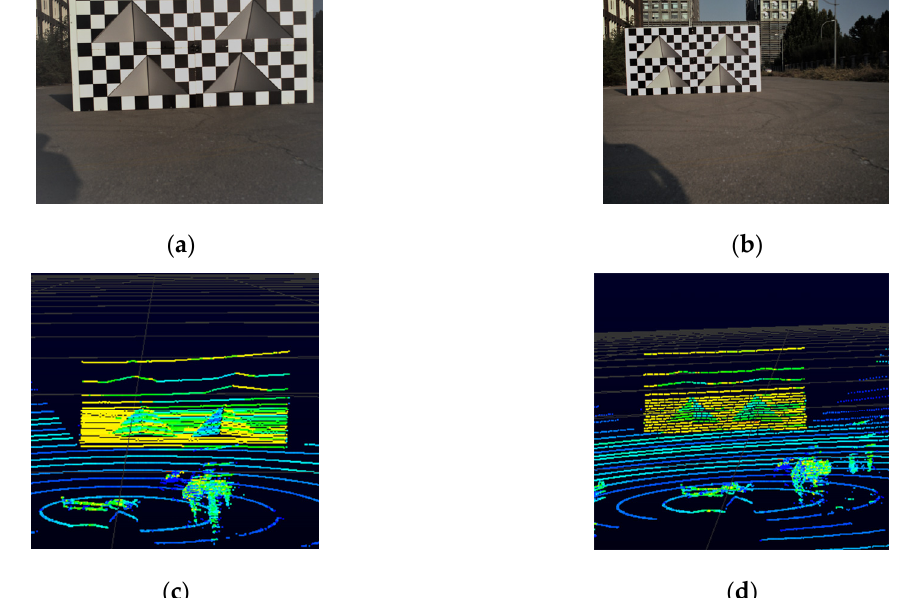
Figure 7. Data collected during calibration experiments. ( a ) The image data obtained by camera at 5 m. ( b ) The image data obtained by camera at 10 m. ( c ) The point cloud data obtained by LiDAR at 5 m. ( d ) The point cloud data obtained by LiDAR at 10 m.